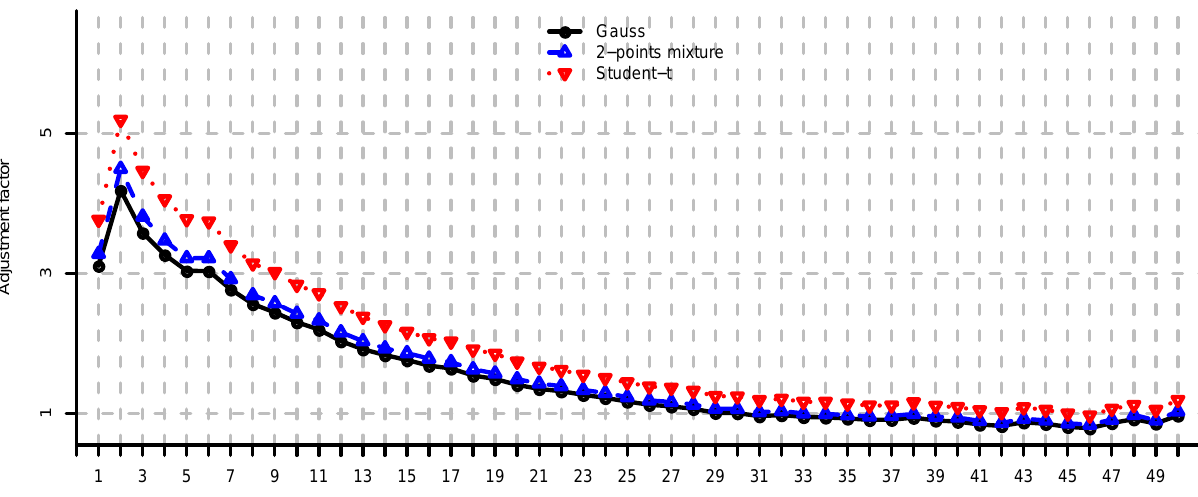
Figure 9. Adjustment factors (11) computed by simulation for N = 1000 and m = 100 , for each